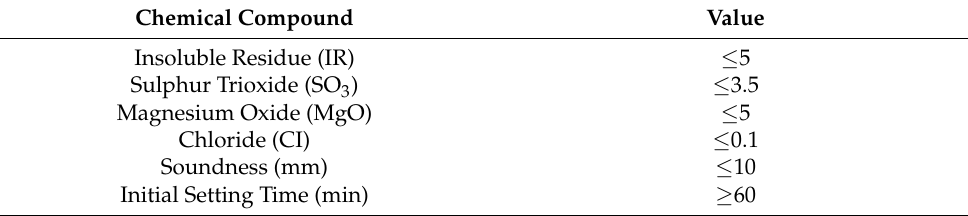
Table 1. Chemical composition of cement.